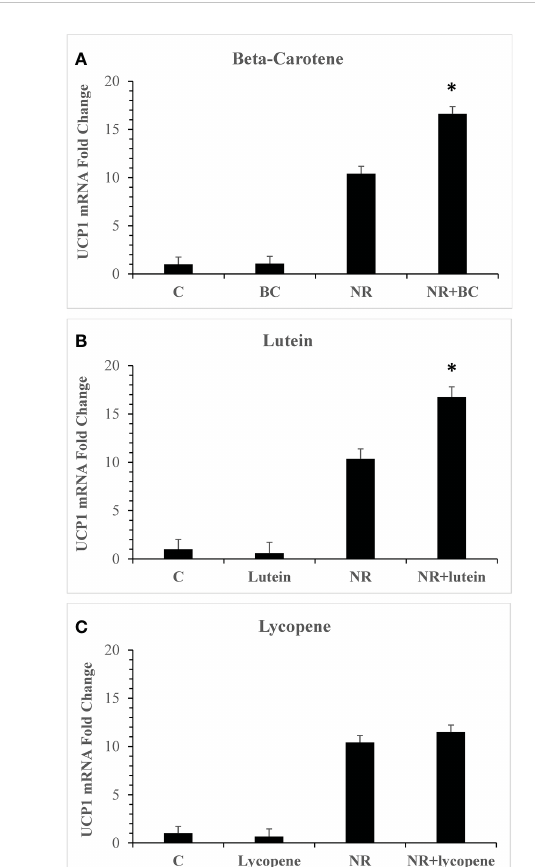
FIGURE 1 Pro-vitamin A carotenoids and NR act synergistically to elevate levels of UCP1 mRNAs Adipocytes from 4 donors with obesity were treated for seven days with vehicle (control) or 8µM NR and 2µM carotenoids. (A) NR+BC (B) NR+Lutein (C) NR+Lycopene mRNA levels were measured using quantitative RTPCR. Data is expressed in least squares means ± standard error. Synergy for mRNA was calculated as: sum of differences ((NR- Control) + (BC - Control)) vs (NRBC - Control). *p < 0.001 for synergy, sum of differences versus NRBC. NR, naringenin; BC, beta study because it is safe, stable, bioavailable and has a long half-life in circulation (50). Adipocytes from fi ve donors with body mass index (BMI) ranging from 27 to 36kg/m 2 were treated with NRBC for seven days. NRBC synergistically boosted mRNA levels for UCP1 (p<0.005), GLUT4 (p<0.02), ATGL (p<0.04) and adiponectin (p<0.05) compared to NR or BC alone (Figure 2A). Protein levels showed a similar trend (Figures 2B, C). Uncropped Western blots are shown in Supplemental Figure 1. ATGL is the rate-limiting lipase for hydrolysis of fatty acids from triglycerides (TGs) (51). GLUT4 is a transporter for glucose uptake, and its upregulation in adipocytes stimulates a cascade of events that reduce insulin resistance (52, 53). Adiponectin is a key circulating factor that acts on muscle and other tissues and improves whole body glucose homeostasis (54). In a previous study we reported induction of CPT1 b mRNA in adipocytes after NR treatment (25). We did not see an increase in CPT1 b levels with NRBC treatment in comparison to levels induced by NR alone.